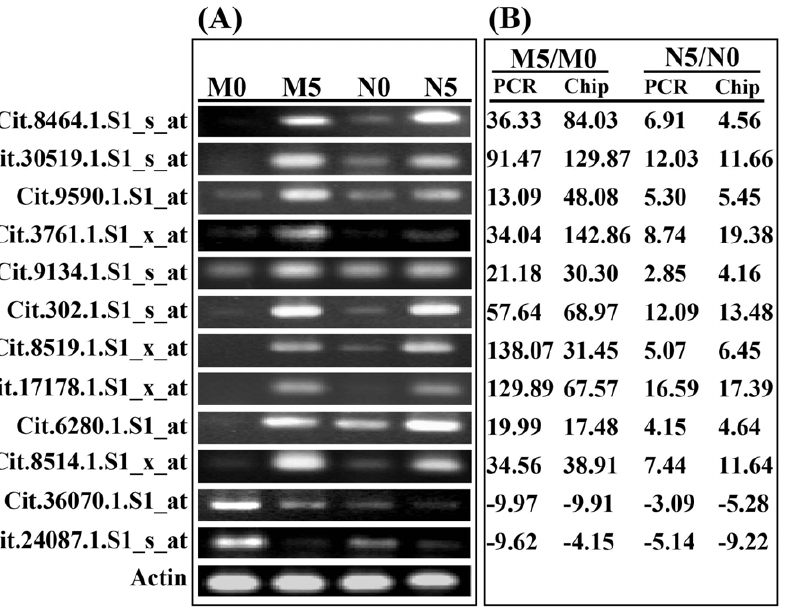
Figure 3. Verification of the microarray results by semi-quantitative RT-PCR. (A) RT-PCR results of the genes. The cDNA of ‘Meiwa’ and ‘Newhall’ leaves sampled at 0 (designated as M0 and N0, respectively) and 5 (designated as M5 and N5, respectively) days post inoculation (DPI) was amplified with specific primers of the selected genes, using Actin as a control. (B) Comparison of the expression ratios (M5/M0 and N5/N0) between RT-PCR analysis and the microarray data. The expression ratios were calculated by quantifying the band density using the Quantity One software.